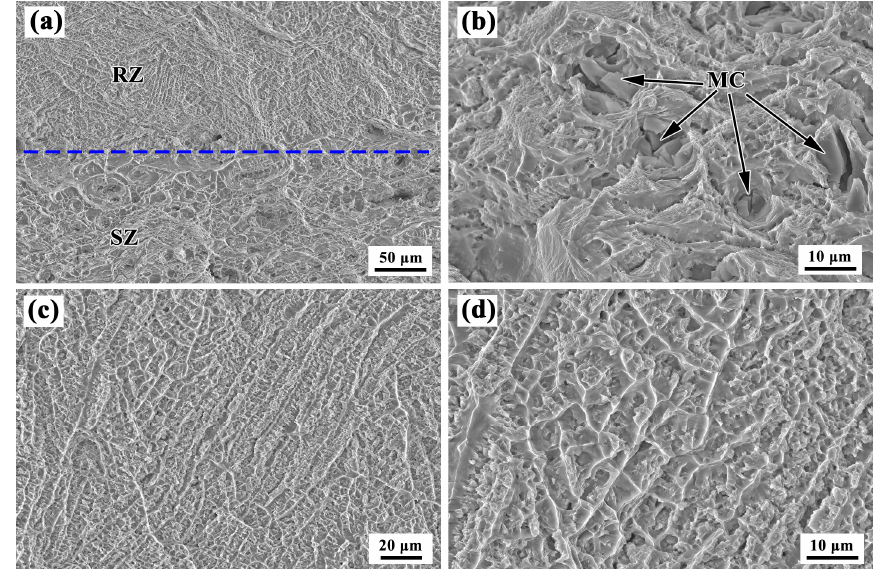
Figure 18. Fractograph of the LARed sample: ( a ) SZ+RZ, ( b ) SZ, and ( c , d ) RZ.